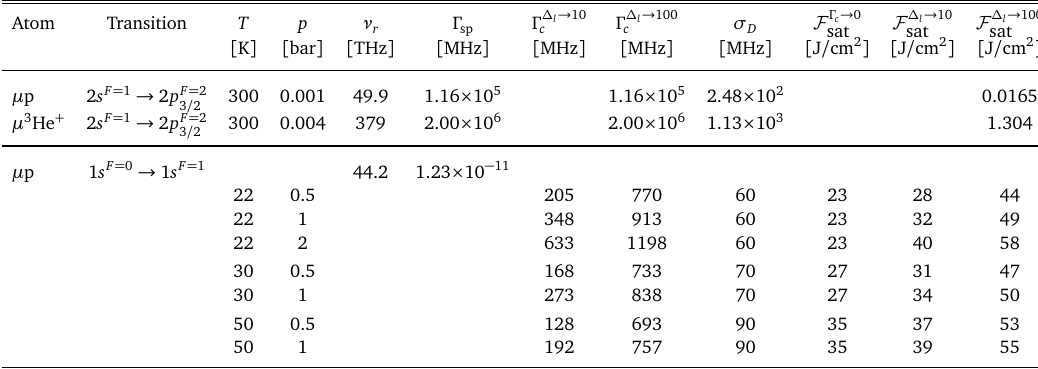
Table 3: Saturation fluences for laser bandwidths of ∆ ∆ → 100 ∆ = 100 MHz ( l ) for three transitions in muonic atoms, accounting for sat l F collisional effects. For comparison we also give the saturation fluence neglecting Γ → 0 c decoherence effects ( ). The resonance frequencies ν sat F transitions have been taken from Refs. [ 5,45,46 ] . The spontaneous decay rates Γ sp of the 2 p states were taken from [ 47 ] and [ 48 ] , while for the ground state triplet in µ p it is calculated here. The decoherence rates Γ tion (5) with the values from Table 1 assuming a Boltzmann distribution between ortho- and para-H (for a statistical distribution see Appendix B). σ 2 standard deviation